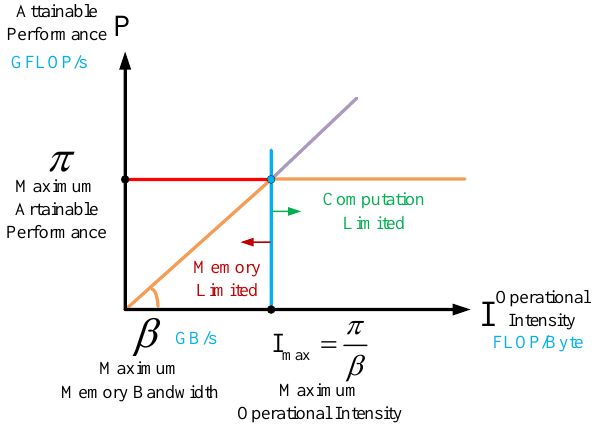
Figure 9. Roof-line model.